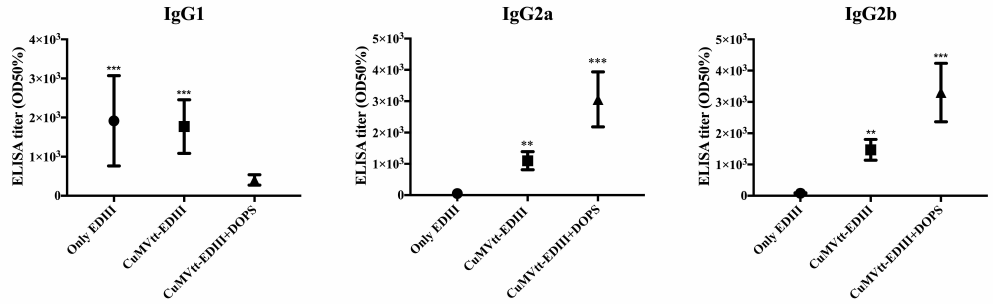
Figure 3. Subclasses of IgG. The figure shows the specific subclasses of IgG induced by each vaccine from samples collected three weeks after the third vaccination (Day 63). The group of mice vaccinated with only EDIII predominantly produced IgG1 while EDIII coupled to VLP (CuMVtt-EDIII) also induced IgG2a and IgG2b. When DOPS adjuvant was ad-mixed, this skewing towards IgG2a and b was even more pronounced. The results were analysed using GraphPad Prism software applied to assess the means of three groups by one-way analysis of variance (ANOVA). The values observed in the negative control group were subtracted from the titres of the other experimental groups. Note: ** p < 0.001, *** p < 0.0001.